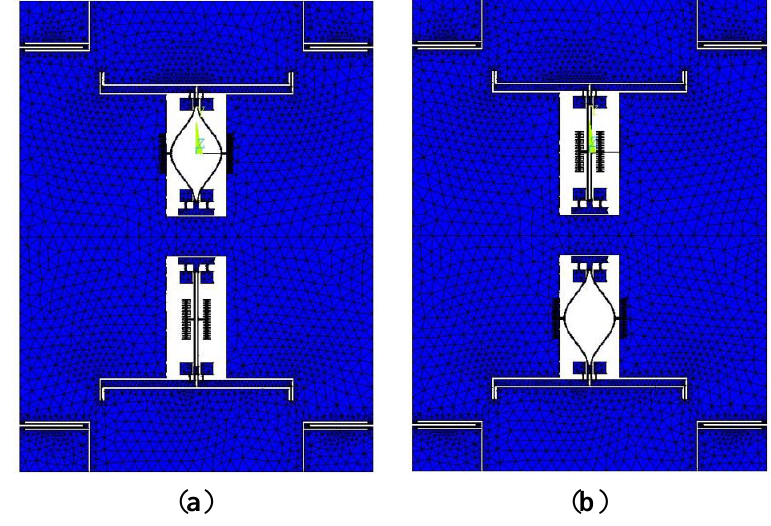
Figure 10. The working modes of the improved accelerometer. ( a ) The working mode of the upper resonator; ( b ) The working mode of the lower